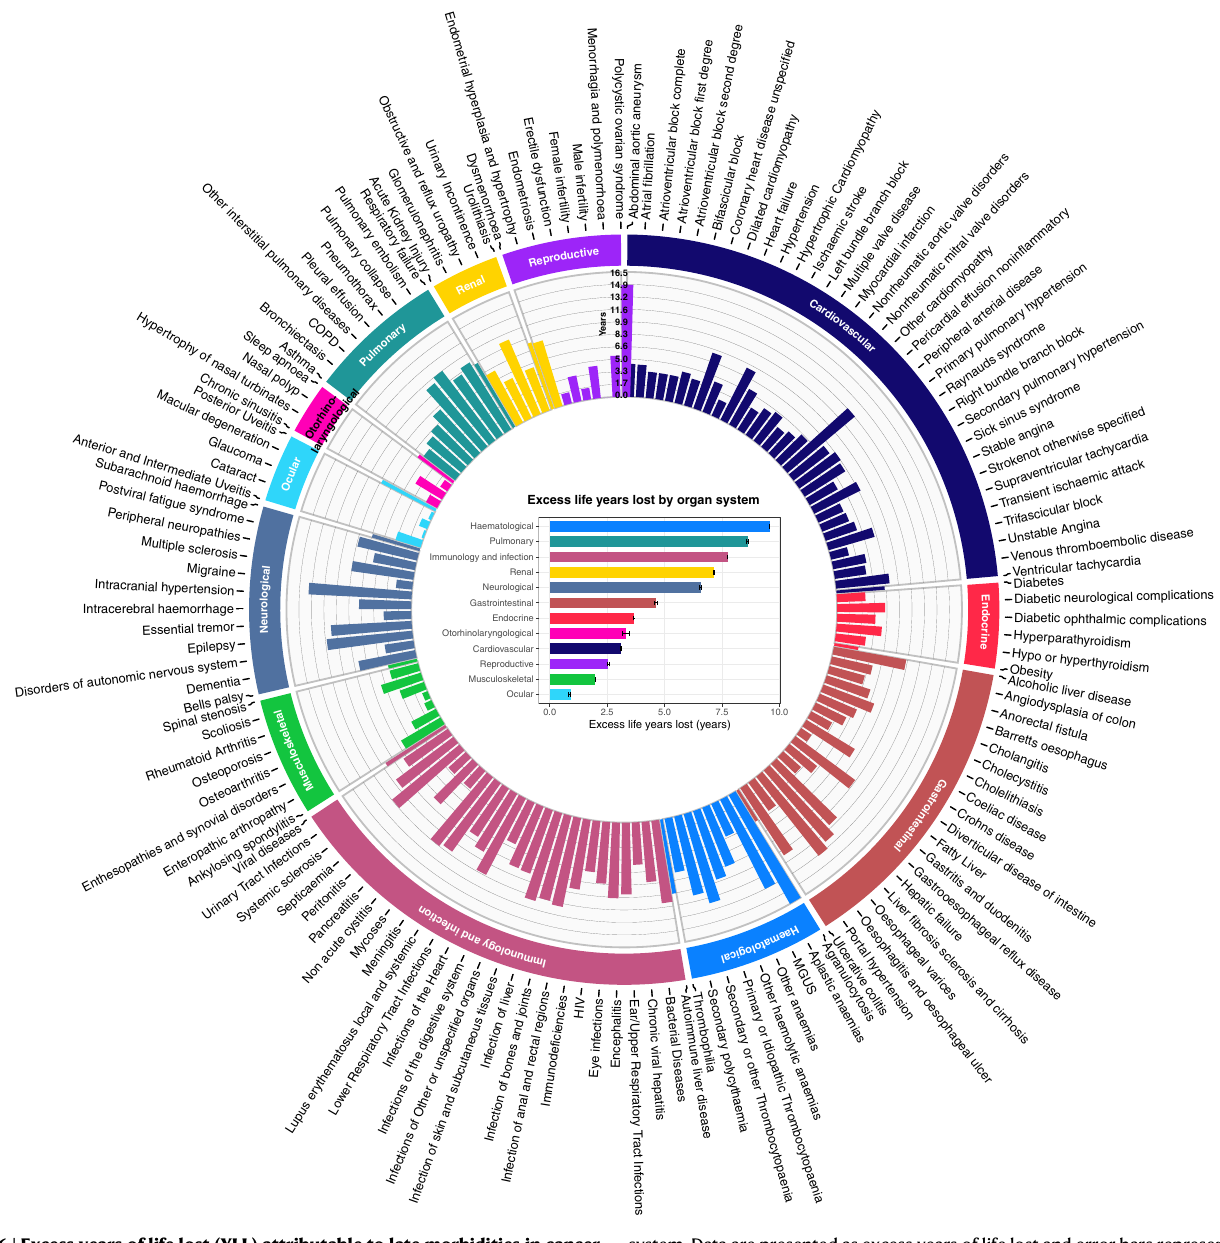
system.Dataare presentedasexcess years of lifelostand errorbarsrepresent95% con fi denceintervals. The number of cancersurvivorswas 243,767. Source data are provided as a Source Data fi